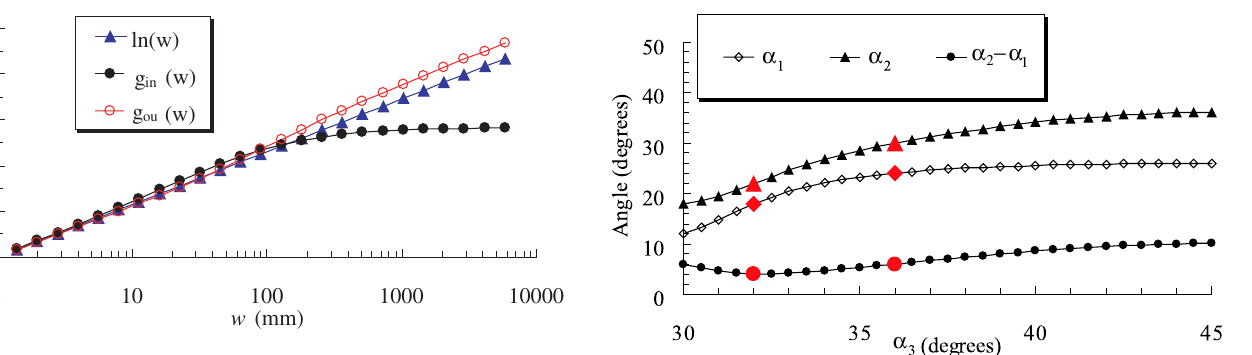
FIG. 30. (Color) One-parameter family for a single layer shell (cid:2) 0 . The two solutions shown in Fig. 7 are and B that sets B 6 10 indicated by larger markers.